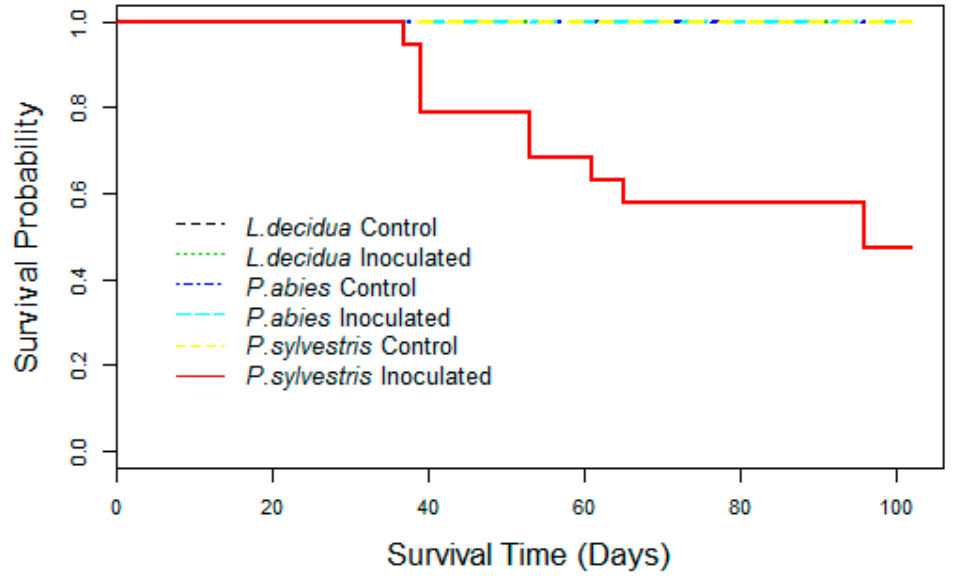
Figure 1. Plot of survival probability determined using the Kaplan-Meier estimate of the survival function for Pinus sylvestris , Picea abies , and Larix decidua seedlings infected with Fusarium circinatum . Note: no mortality was recorded for inoculated seedlings of P. abies and L. decidua and all control seedlings. For this reason, all of these curves overlap in a straight line making it difficult to distinguish them.